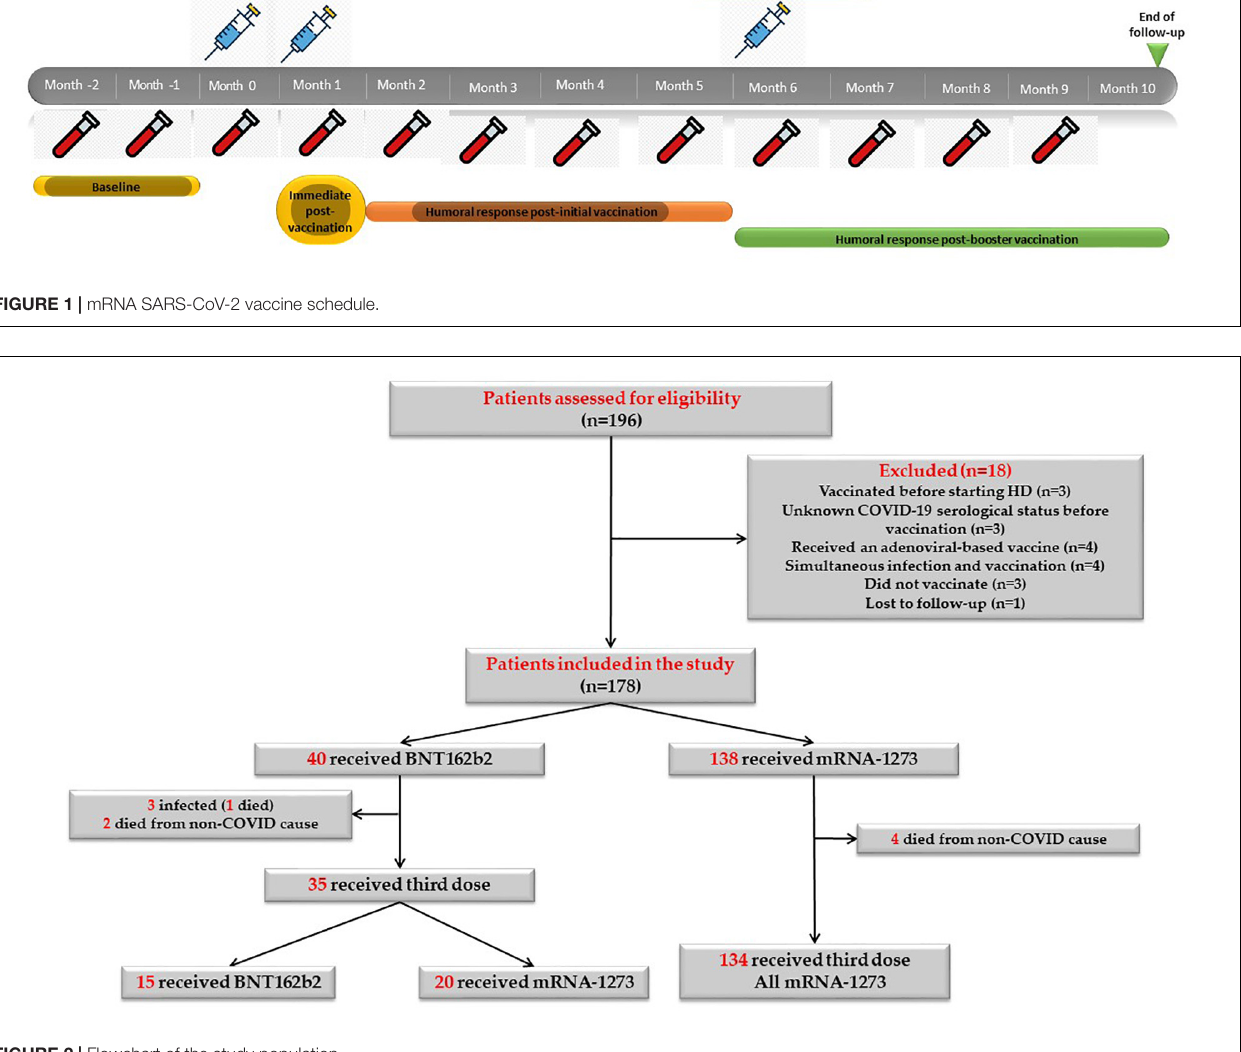
FIGURE 2 | Flowchart of the study